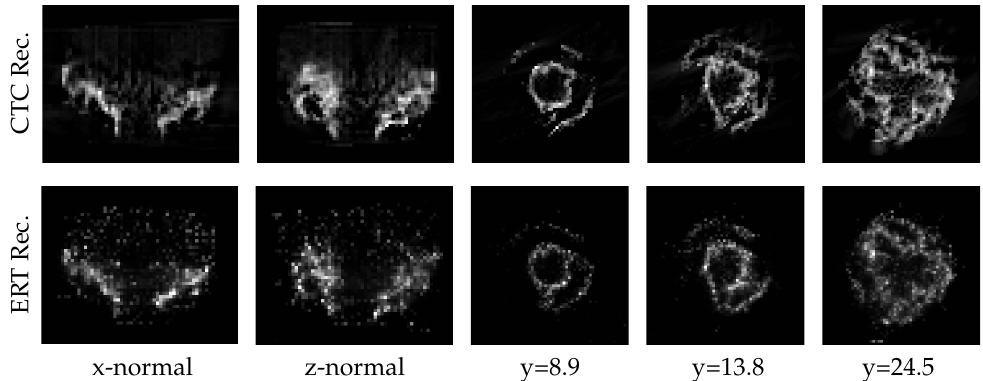
Figure 14. Vertical slices at the flame center (x-normal and z-normal), and horizontal slices at different heights above burner exit (in mm).